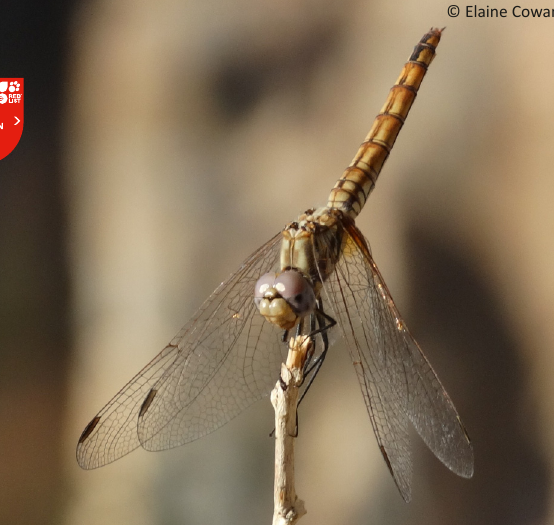
Image 25. Female Trithemis annulata , 9 April 2014. Yellowish-brown abdomen with dorsal line and thick black bar on segments 8 and 9. Amber patch at hindwing